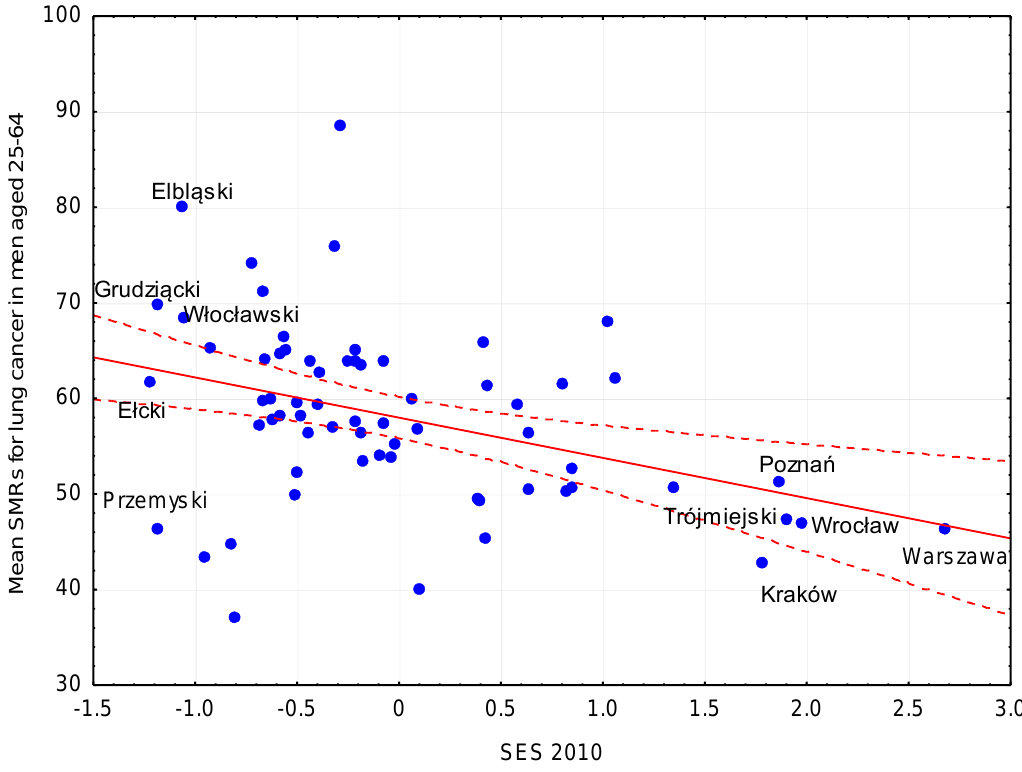
Figure 2. Relationship between SES index in 2010 and mortality due to lung cancer in men aged 20 – 64.